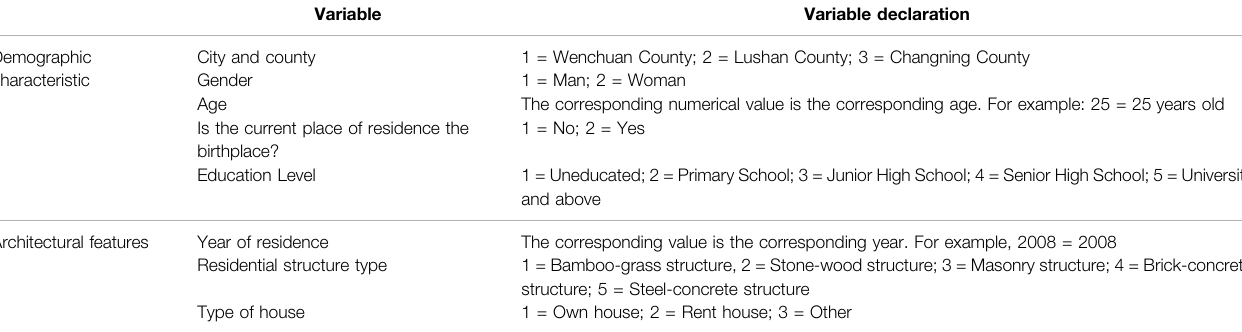
TABLE 1 | Selection and explanation of social demographic